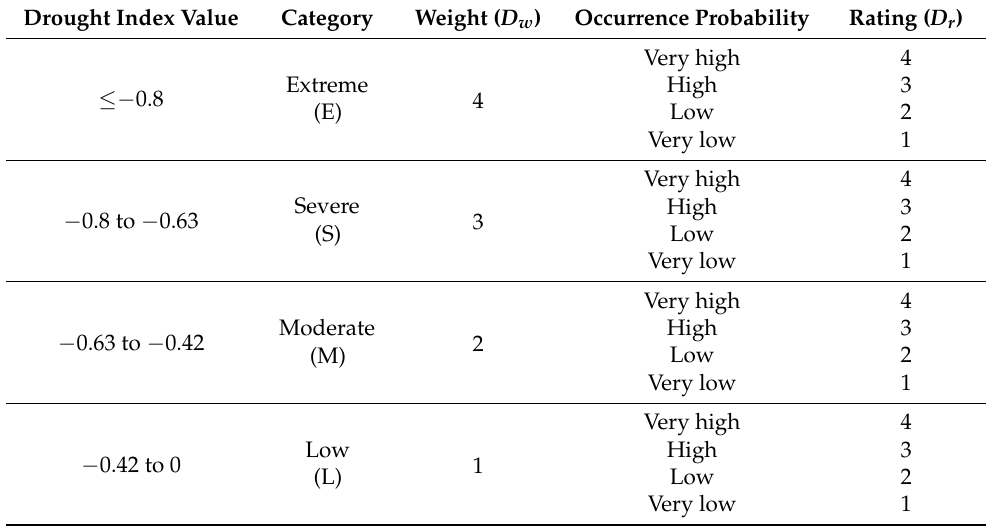
Table 2. Weight ( D w ) and rating ( D r ) for each drought category and probability of occurrence. Drought Index